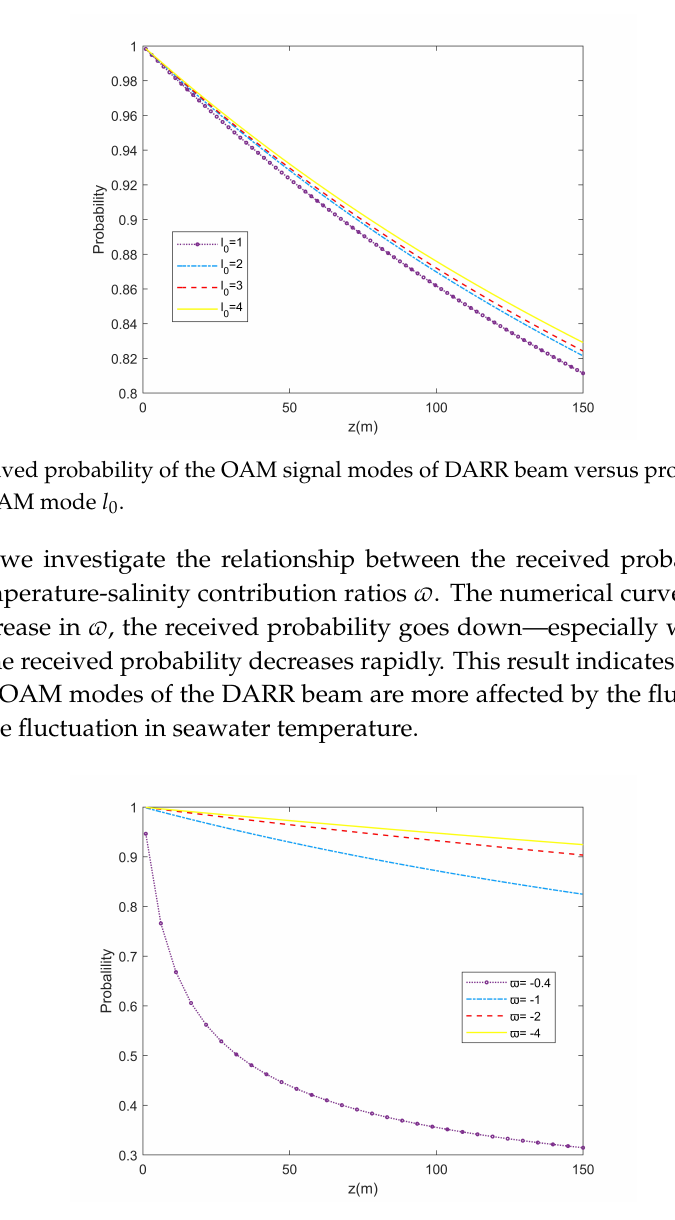
Figure 2. Received probability of the OAM signal modes of DARR beam versus propagate distance Z for different temperature–salinity contribution ratios (cid:118)